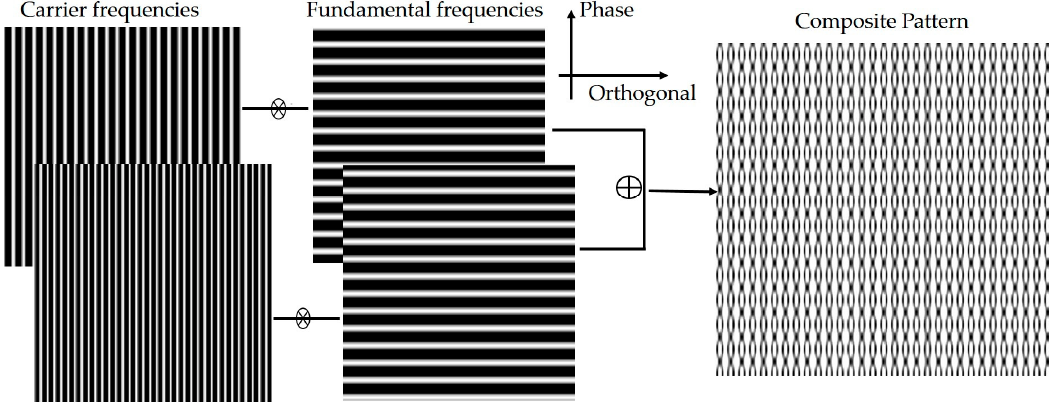
Figure 1. Composite pattern (CP) composed by the phase-shifting fringes and carrier gratings.